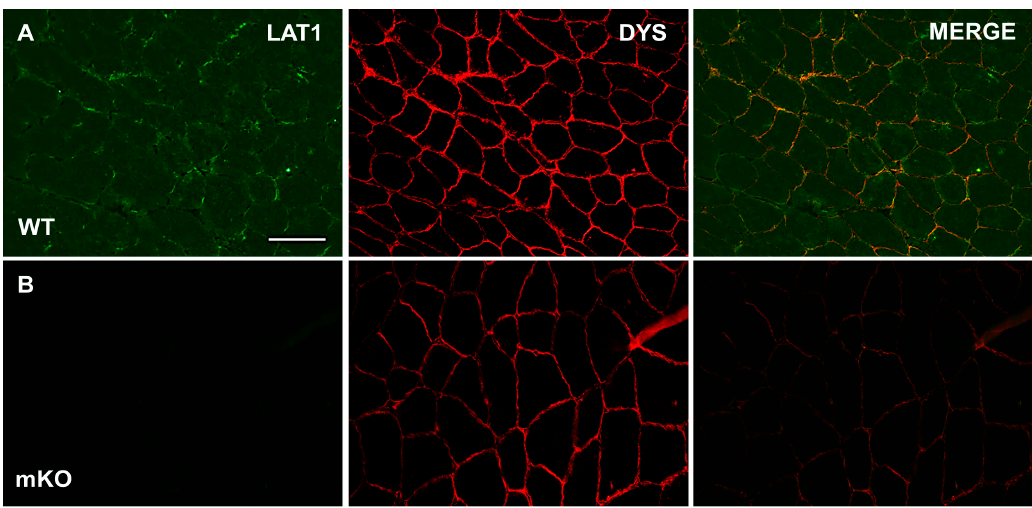
Figure 1. Immunofluorescent detection of L-Type amino acid transporter 1 (LAT1) in wild type (WT) and LAT1 muscle-specific knockout (mKO) mouse extensor digitorum longus (EDL) muscle. Sections were stained with anti-LAT1 antibody (far left panels, green) and then co-stained with dystrophin (middle panels, red) for the identification of the sarcolemma. Representative images for both WT ( A ) and mKO ( B ) are shown. Scale bar in top left panel is 50 µ m and all images were captured at the same magnification.